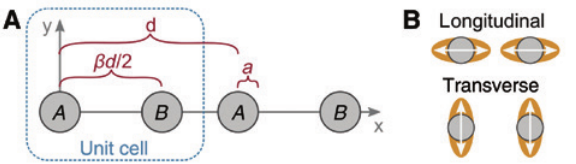
Figure 1: A depiction of the plasmonic chain and the polarisation of its modes. (A) The schematic diagram of the topological plasmonic chain and (B) the two distinct and decoupled